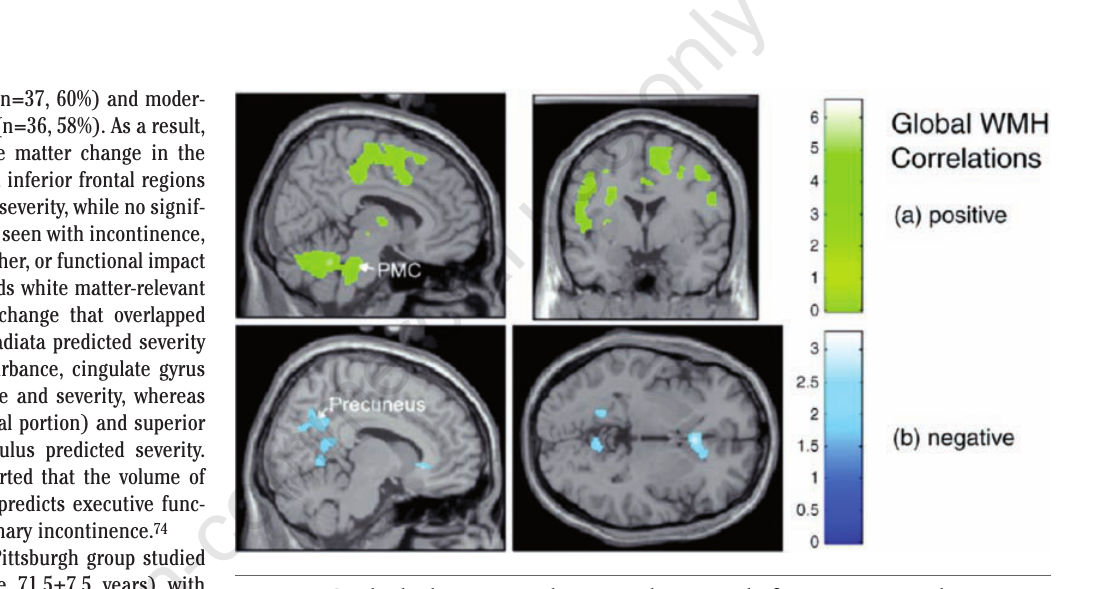
Figure 3. Cerebral white-matter changes and urinary dysfunction. Regional activations ( e.g. medial/superior frontal gyrus adjacent to dorsal anterior cingulate gyrus, cerebellum and pontine micturition center [PMC]) have positive correlations with global white mat- ter change (upper panel), while some regional activations ( e.g. precuneus, etc.) have neg- ative correlations. Reproduced with permission.